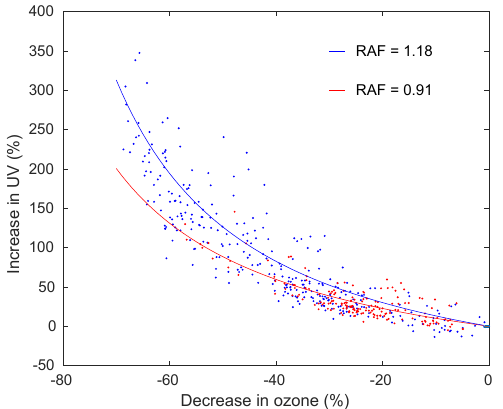
Figure 9. Total ozone decrease from the highest total ozone value measured in Marambio during the measurement period 2000–2010 and the corresponding increase in erythemally weighted irradiances. Blue dots correspond to months when there is probably more snow on the ground (August, September, October, March and April) and the red dots correspond to summer months (November, December, January and February). The RAF is shown for the two periods and the theoretical increases in UV radiation using the RAFs are plotted as